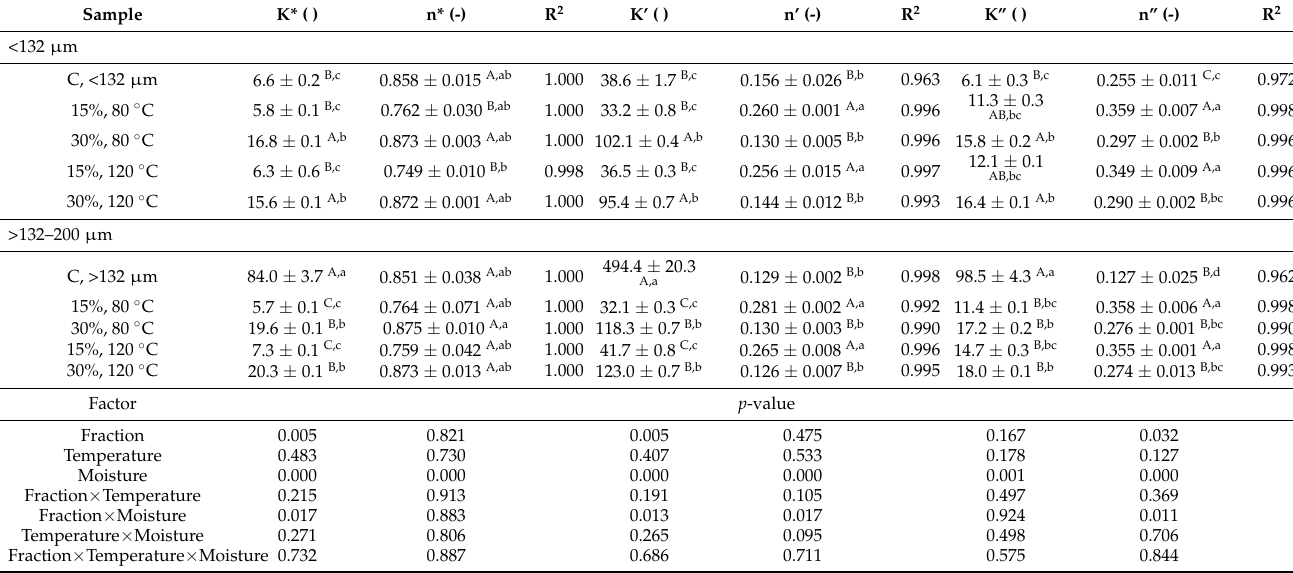
Table 4. The viscoelastic properties of